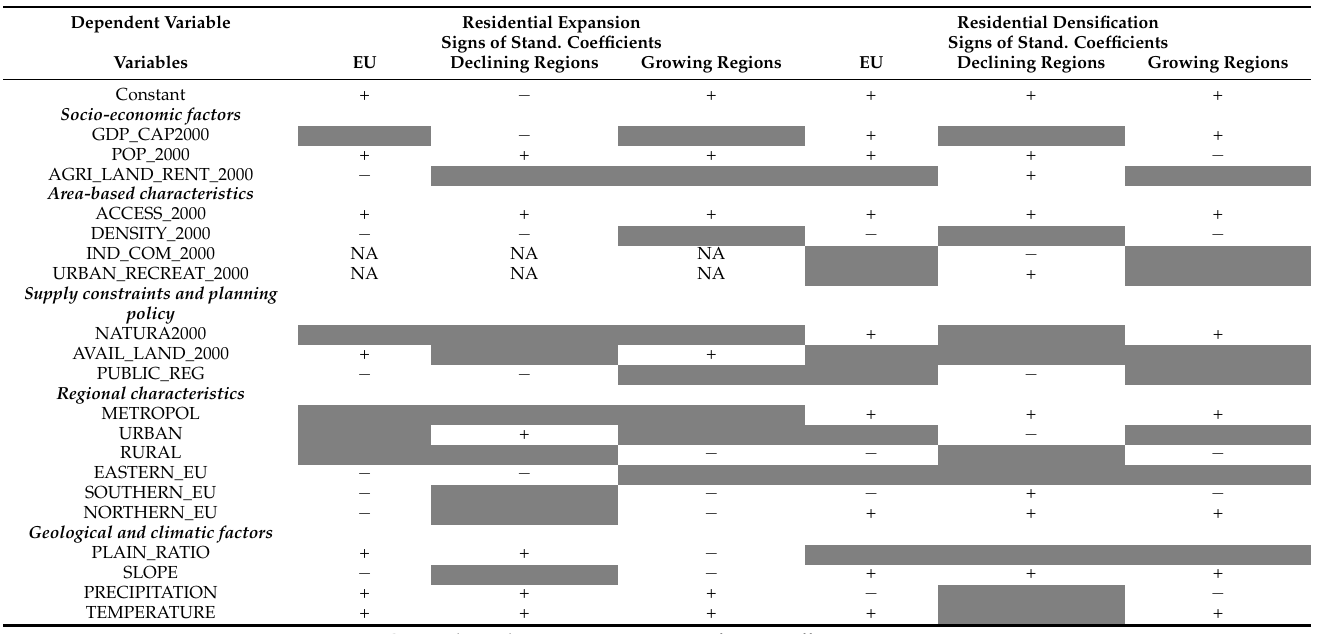
Note: Grey-coloured areas represent insignificant